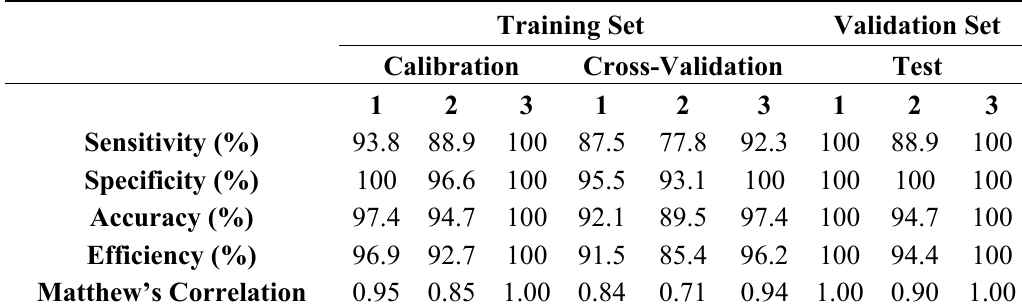
Table 2. Classification parameters obtained for PLS-DA. 1. Chicken frankfurters; 2. Turkey frankfurters; 3. Mixture meat